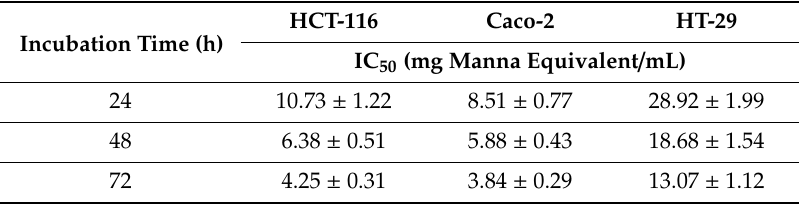
Figure 1. Inhibitory e ff ect of HME on the growth of colon cancer cells. Cell monolayers were incubated for 24–72 h with HME. Cell viability was assessed by MTT test as reported in the Methods. Results are indicated as the percentage of viable cells with respect to untreated controls. Values are the mean ± SD of three separate experiments carried out in triplicate. Table 1. Calculated IC 50 values for the anti-proliferative activity of HME in various human colon cancer cell lines at di ff erent